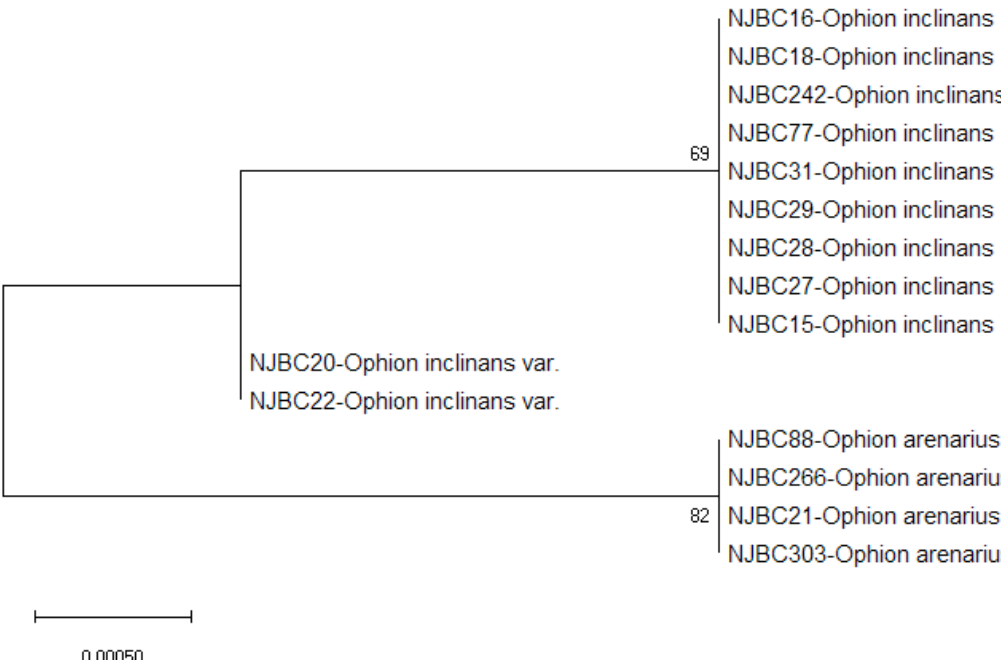
Fig. 5. Phylogeny of Ophion inclinans Johansson sp. nov. and Ophion arenarius Johansson sp. nov. (BIN. BoLD: AAh1753) as obtained from cytochrome oxidase 1 (CoI) sequences. Maximum likelihood